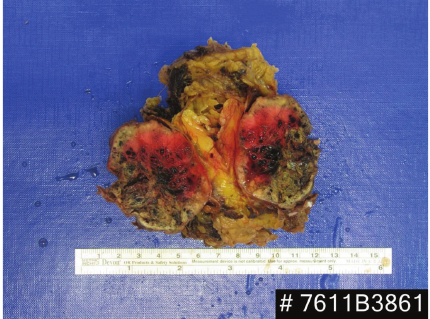
Figure 2: Gross pathologic evaluation of the resected specimen. The tumorwas located in theperi-adrenal fatty tissueoutsidetheadrenal gland.